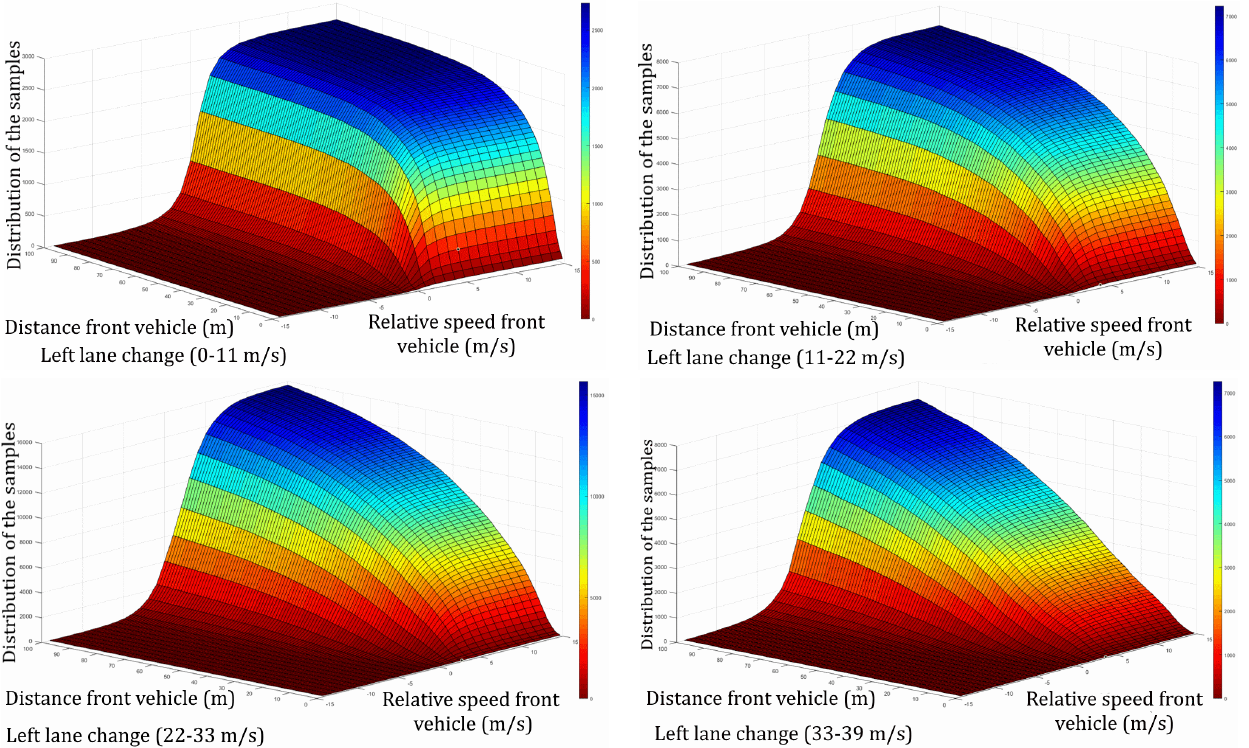
Figure 2. Bi-variant cumulative histogram divided in 4 speed intervals for the front vehicle.